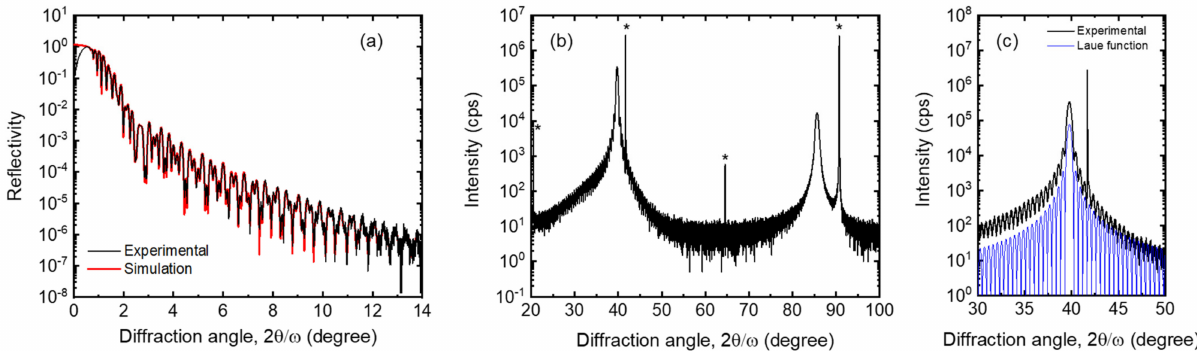
Figure 2. ( a ) X-ray reflection (XRR), ( b ) high-angle 2 θ / ω profile of the film. ( c ) represents the enlarged profile of ( b ) around 2 θ / ω = 30-50 ◦ . Black and red lines in ( a ) represent the experimental result and the fitted result, respectively. Blue line in ( c ) represent the calculated profile using the Laue